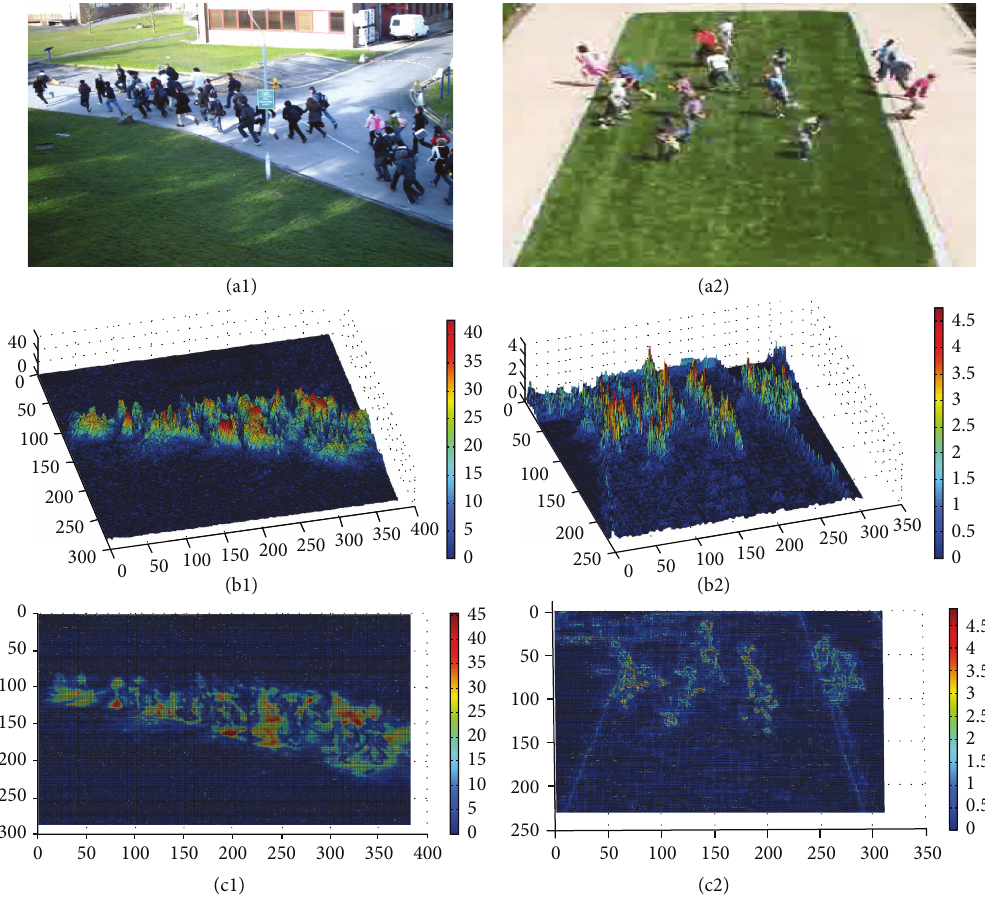
Figure 7: Results of spatiotemporal Weber variation feature. (a1) and (a2) are the original images in the sequences. (b1) and (b2) are the corresponding results of the spatiotemporal Weber force feature. (c1) and (c2) are the top view of spatiotemporal Weber force